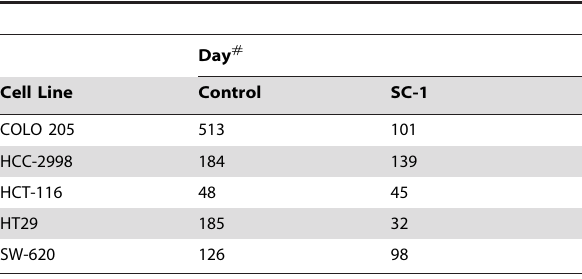
Table 2. Calculated Time to 1000 mg Tumor Volume in 5 Colon Lines Forming Tumors*.